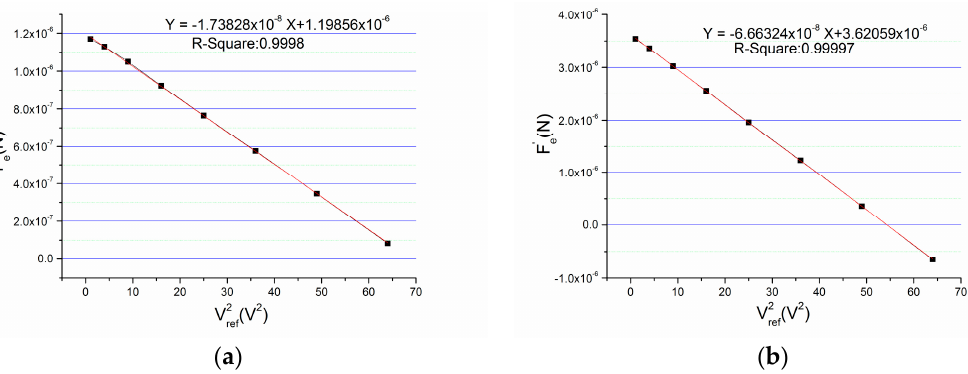
Figure 4. Measuring the equivalent mismatch between fixed plate and GND: ( a ) the initial state; ( b ) state of adding a capacitance of 1 pF.